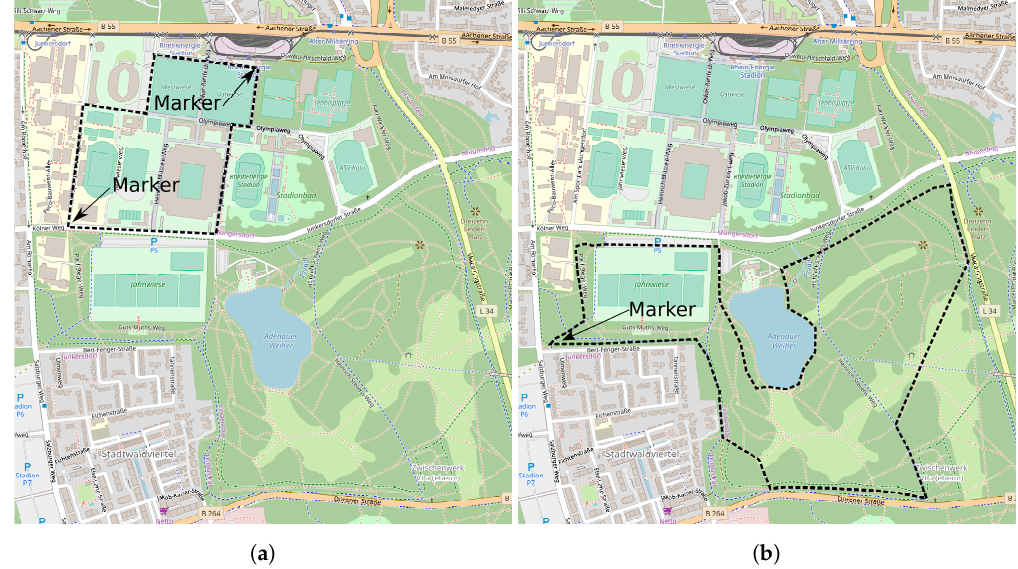
Figure 1. Map view of the tracks for both study groups. ( a ) Map view of the 2 km track for the untrained runners., ( b ) Map view of the 5 km track for the trained runners. Map views were created using c (cid:13) OpenStreetMap